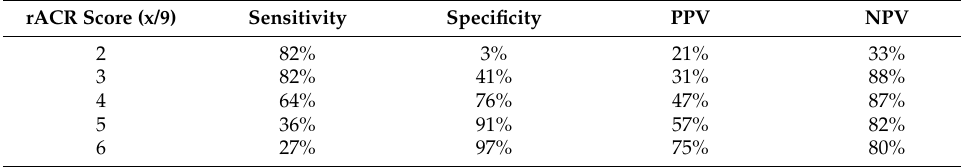
Table 7. Performance scores for rACR (pre-test) and